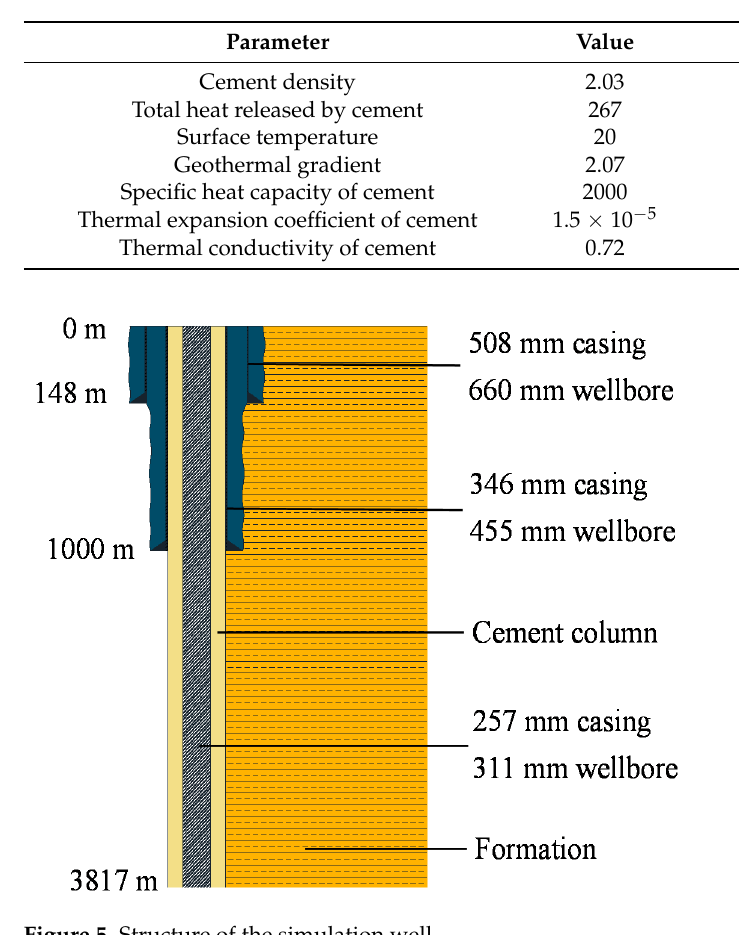
Figure 5. Structure of the simulation well.